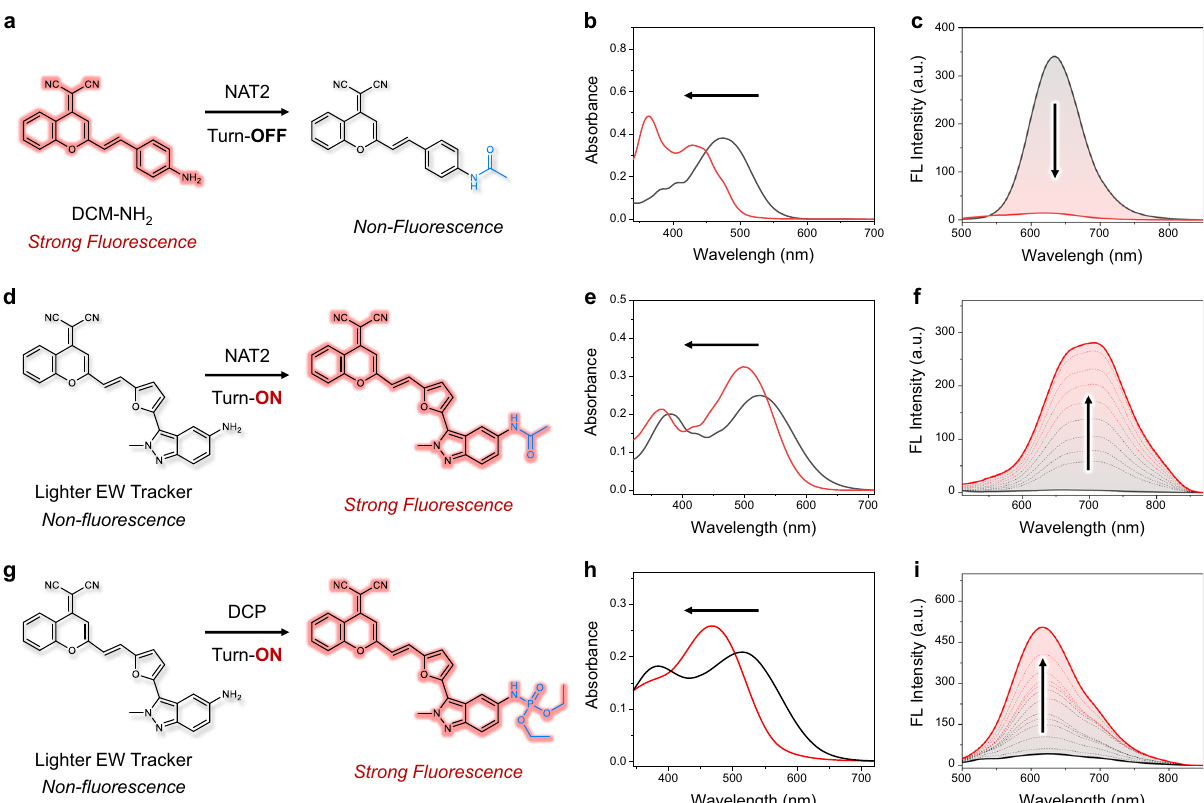
Fig. 5 Distinctly different fl uorescence response between traditional ICT probe (quenching mode) and indazole-based ICT probe (light-up mode) for sensing EWTs. a – f The proposed sensing mechanism of DCM-NH 2 ( a quenching mode) and Lighter EW Tracker ( d light-up mode) for NAT2. UV-vis absorption and emission spectra of DCM-NH 2 ( b , c λ ex = 450 nm, 10 μ M) and DCM-IN-NH 2 ( e , f λ ex = 500 nm, 10 μ M) upon addition of NAT2 mimic (acetyl chloride, from 0 to 2 mM) in acetonitrile solution. g Proposed sensing mechanism of DCM-IN-NH 2 for DCP (light-up mode). UV-vis absorption ( h ) and emission ( i , λ ex = 470 nm) spectra of DCM-IN-NH 2 (10 μ M) upon addition of DCP (from 0 to 3 mM) in acetonitrile